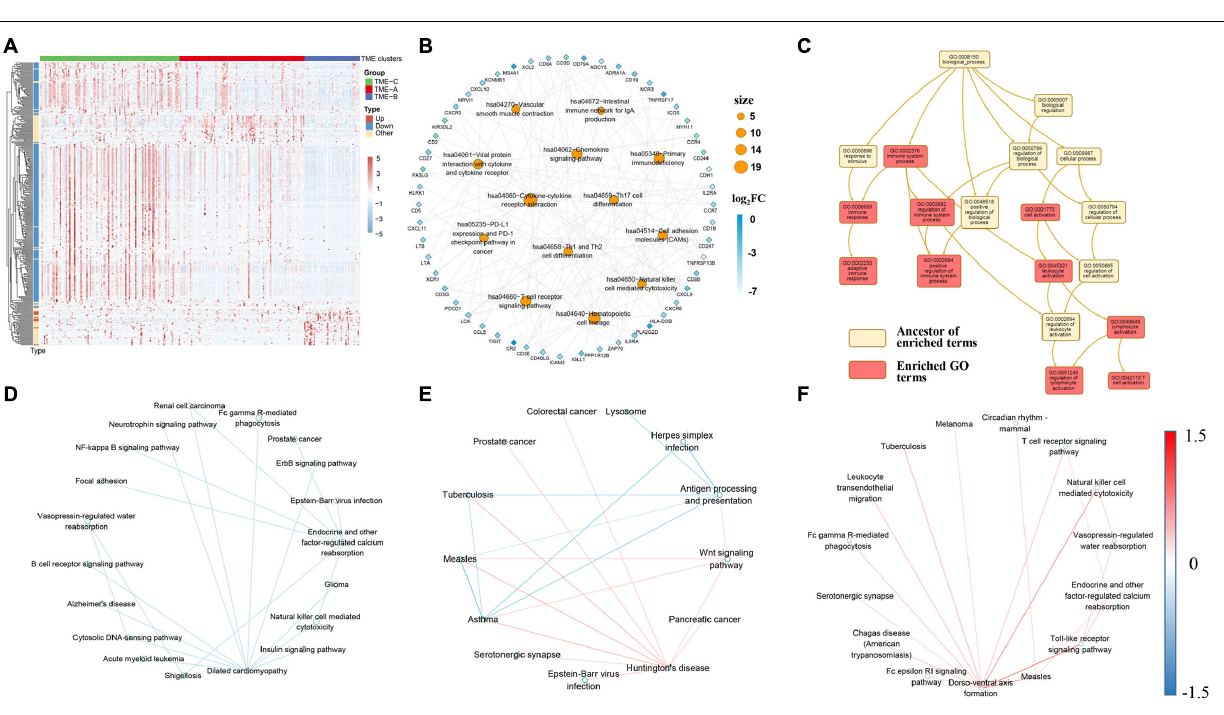
FIGURE 4 | (A) The expression performance of DEGs in three TME groups. Log10 transformed the transcripts per million values of all DEGs. Pearson correlation used as a clustering distance method, and Euclidean distance was performed on the hierarchical clustering of all DEGs. Type represents the changes in expression of DEGs from TME-C to TME-A to TME-B. “Up” represents a continuous increase, “Down” represents a continuous decrease, and “Other” represents increase first then decrease or decrease first then increase. (B) The KEGG pathway enrichment network of DEGs. Orange circular nodes represent KEGG pathways. Diamond nodes represent DEGs. The size of the circle denotes the number of DEGs enriched in the pathway. The color of diamond notes denotes the degree of difference between TME-C and TME-B. (C) Enriched GO terms graph of DEGs and top-ranking neighbors. The yellow box represents the ancestor of enriched terms, and the red box represents enriched GO terms. (D–F) The crosstalk relationship of pathways in three TME groups, and the color of line represents the change of significant pathway correlation. (D) represents the crosstalk between TME-A and TME-B. (E) represents the crosstalk between TME-A and TME-C. (F) represents the crosstalk between TME-B and